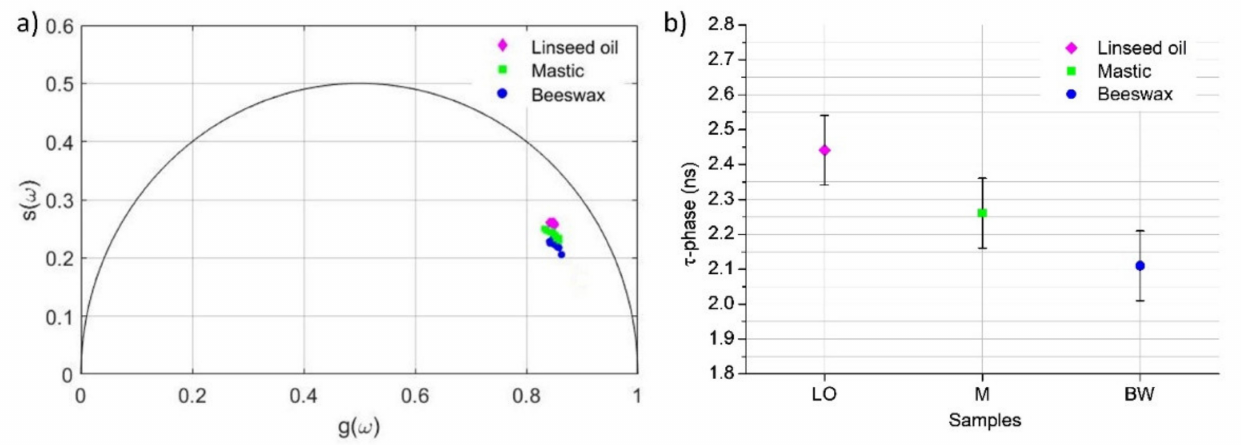
Figure 3. Results of the lifetime phasor analysis of LO, M, and BW samples: phasor plot ( a ) and plot of the mean τ -phase values ( b ), with corresponding standard deviations indicated by the error